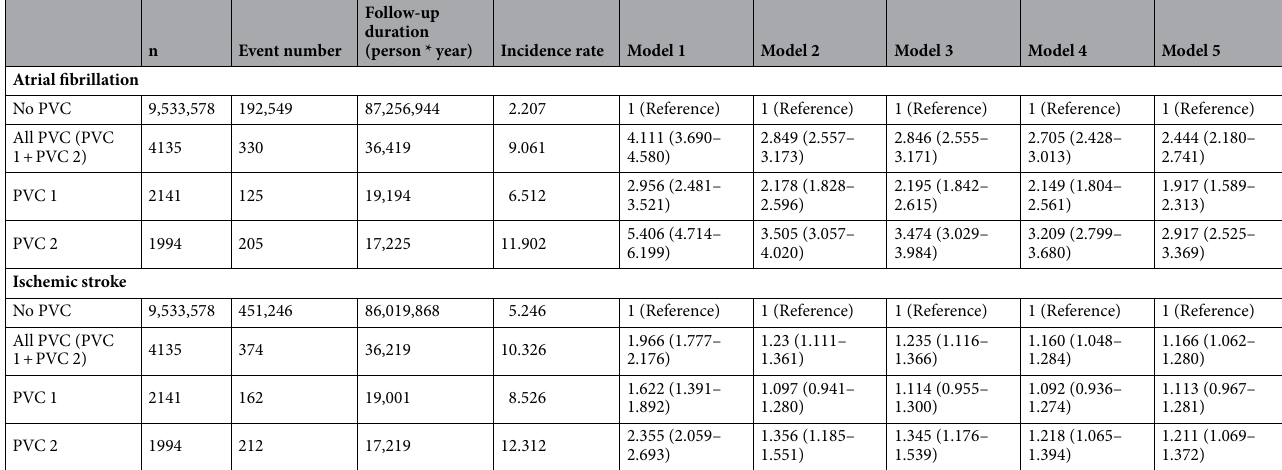
Table 2. The risk of new-onset AF and ischemic stroke in people with PVC. Incidence rate is per 1000 person * years. Model 1 is without multivariate adjustment. Model 2 is adjusted for age and sex. Model 3 is adjusted for age, sex, BMI, smoking status, alcohol consumption, and physical activity. Model 4 is adjusted for age, sex, BMI, smoking status, alcohol consumption, physical activity, hypertension, diabetes, dyslipidemia, and chronic kidney disease. Model 5 is adjusted for age, sex, BMI, smoking status, alcohol consumption, physical activity, hypertension, diabetes, dyslipidemia, chronic kidney disease, myocardial infarction, mitral stenosis, and aortic stenosis. AF atrial fibrillation, PVC premature ventricular contraction.